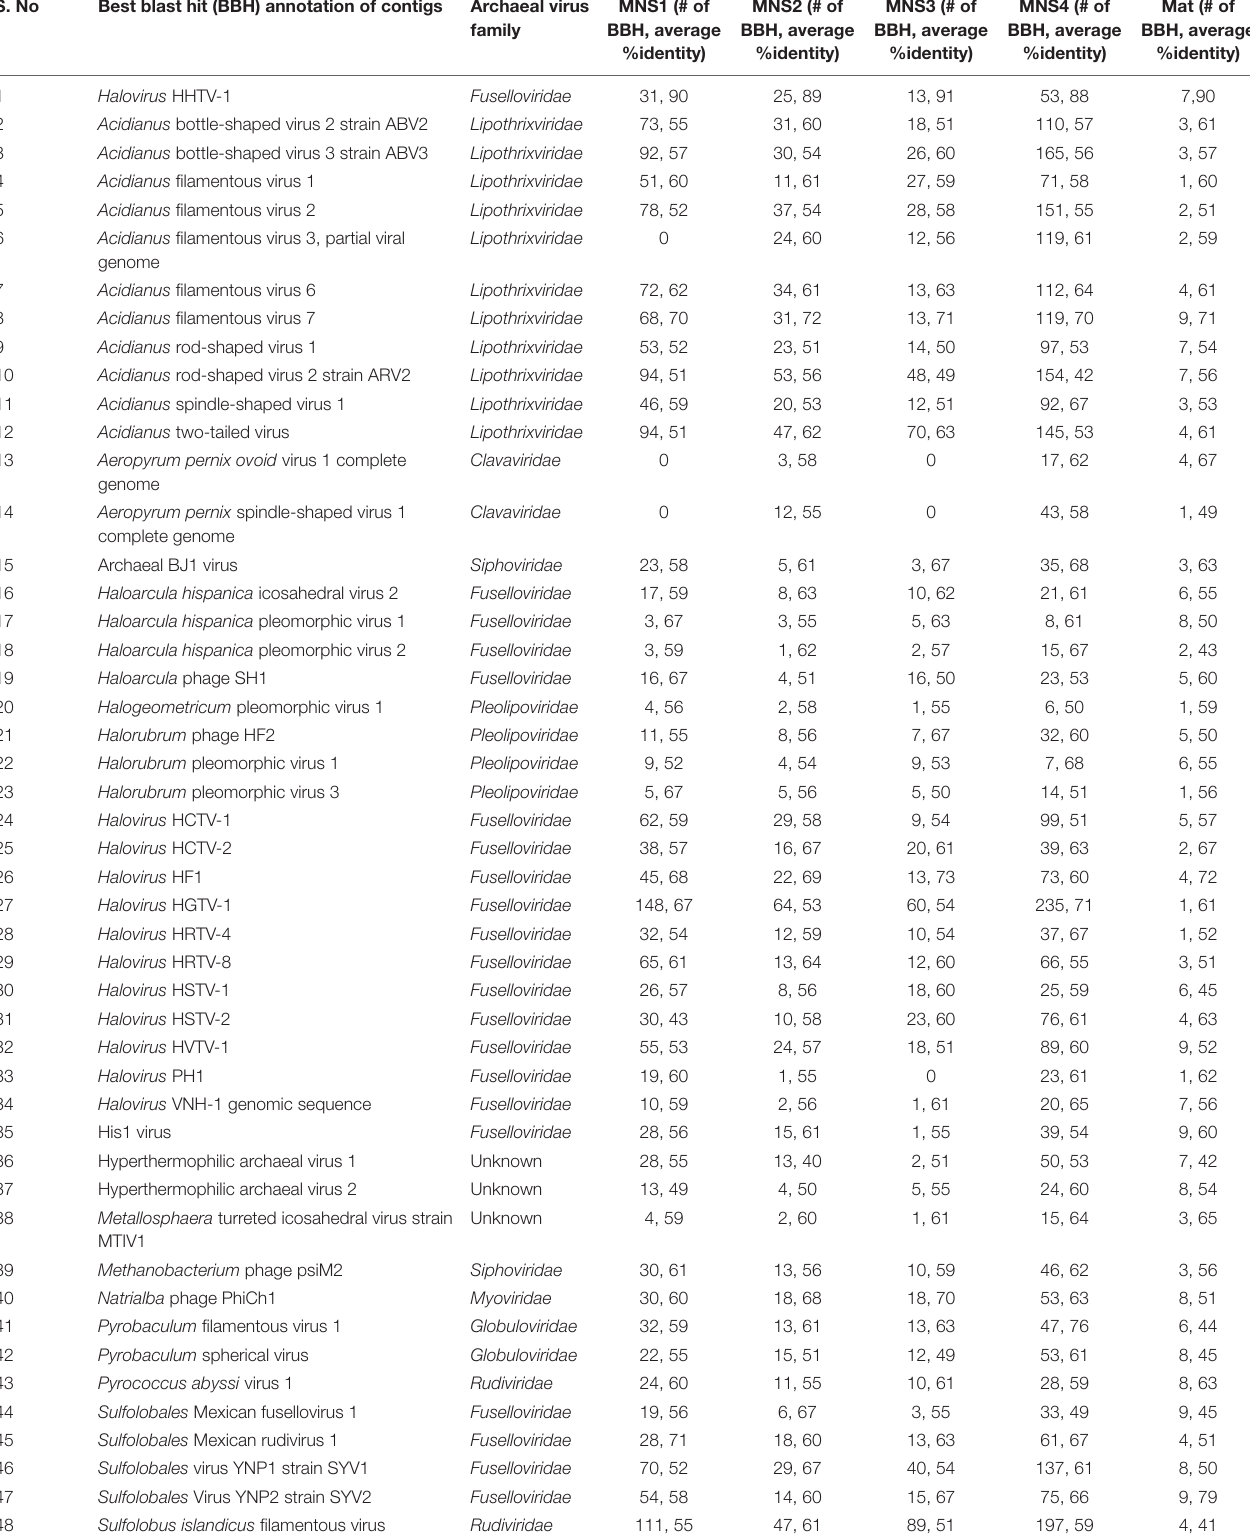
TABLE 3 | The BLASTX results of metagenome contigs from sediments and mat samples, searched against the archaeal virus sequence database. S.